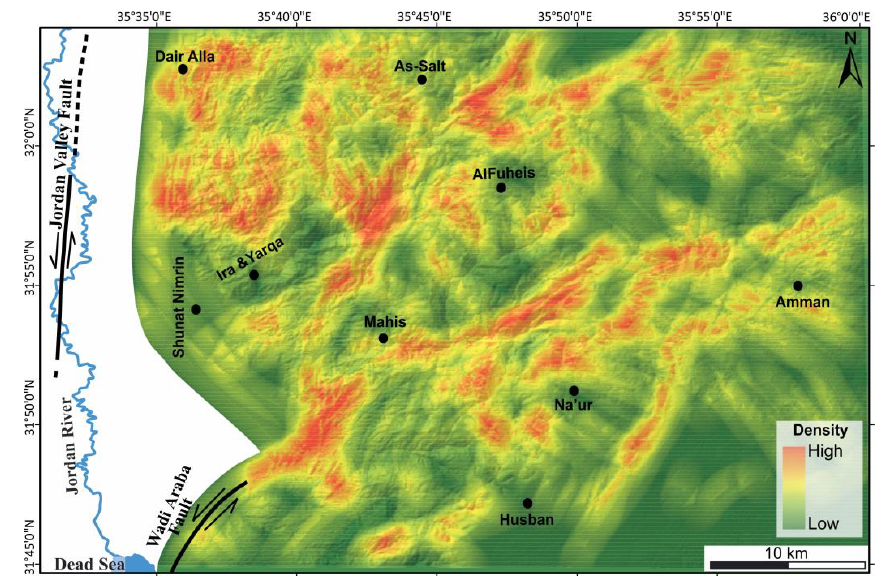
Figure 7. Lineament density map. The red color represents areas with a relatively higher density and the green color represents areas with a relatively lower density .